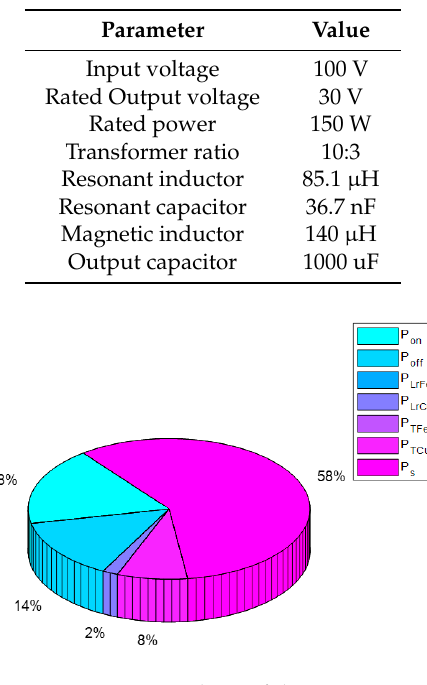
Table 1. Optimal parameters of the LLC resonant converter.